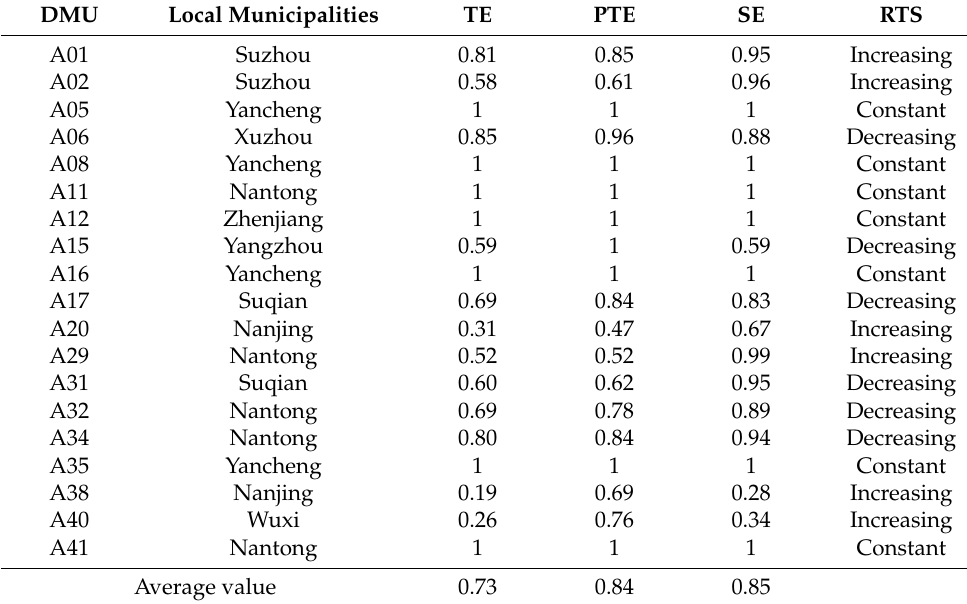
Table 5. Investment efficiency values for the first phase of the 19 projects from the meeting the electricity demand category (sorted by DMU).